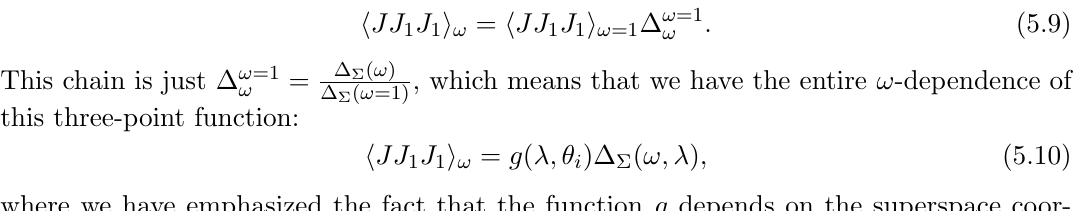
, , . Each external leg can be either a J or a J O 3 O 4 O 5